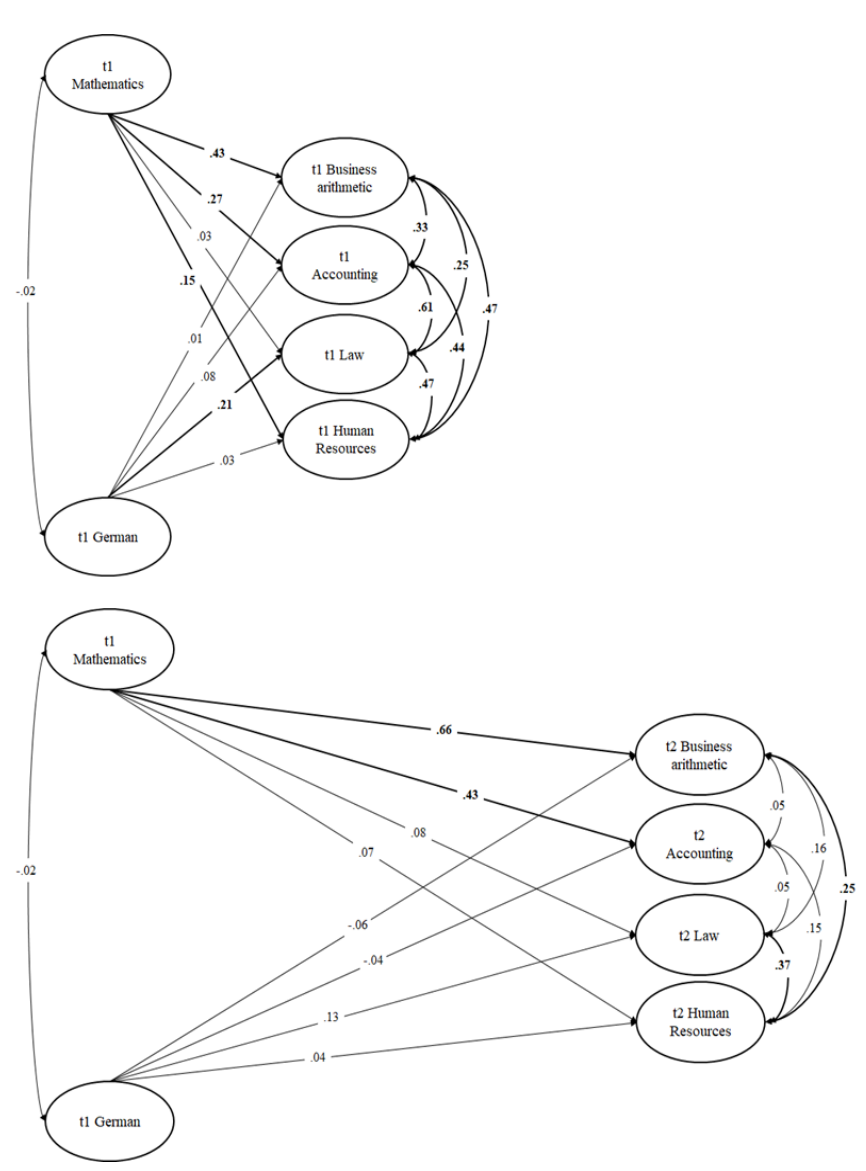
Figure 2. Results from structural equation models regarding intrinsic task